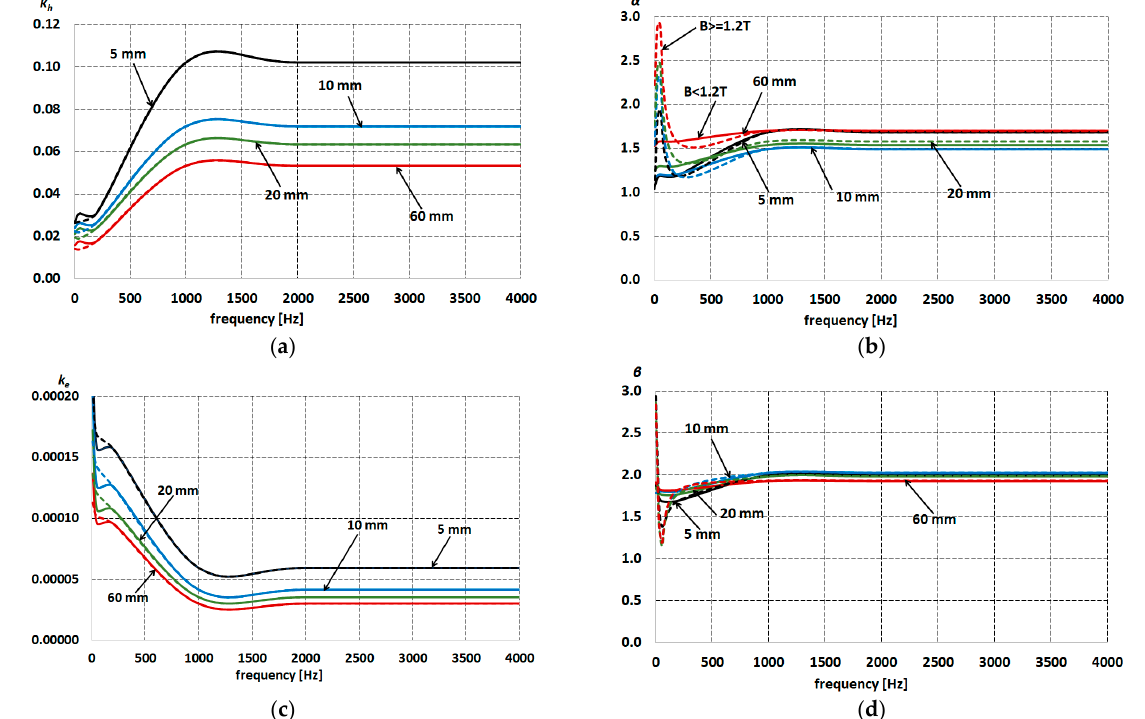
Figure 8. Courses of coefficients ( a ) k h ; ( b ) α ; ( c ) k e ; ( d ) β as a function of frequency for individual widths of M270-35A sheet samples cut with a